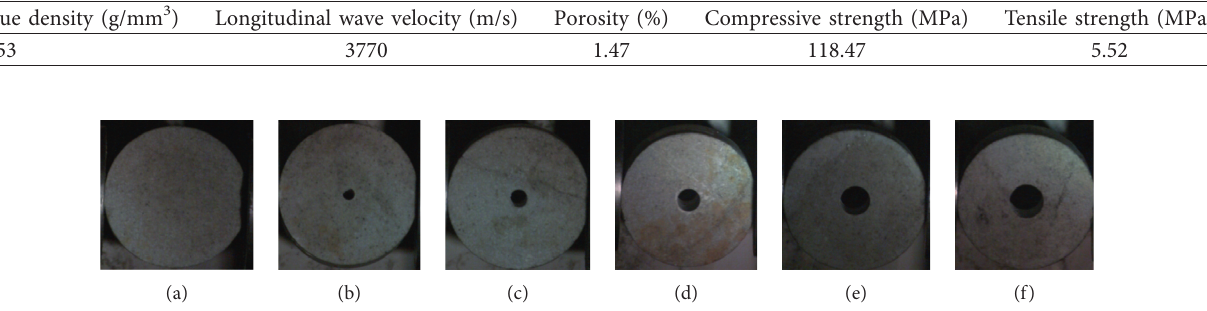
Table 1: Static mechanical properties of sandstone.